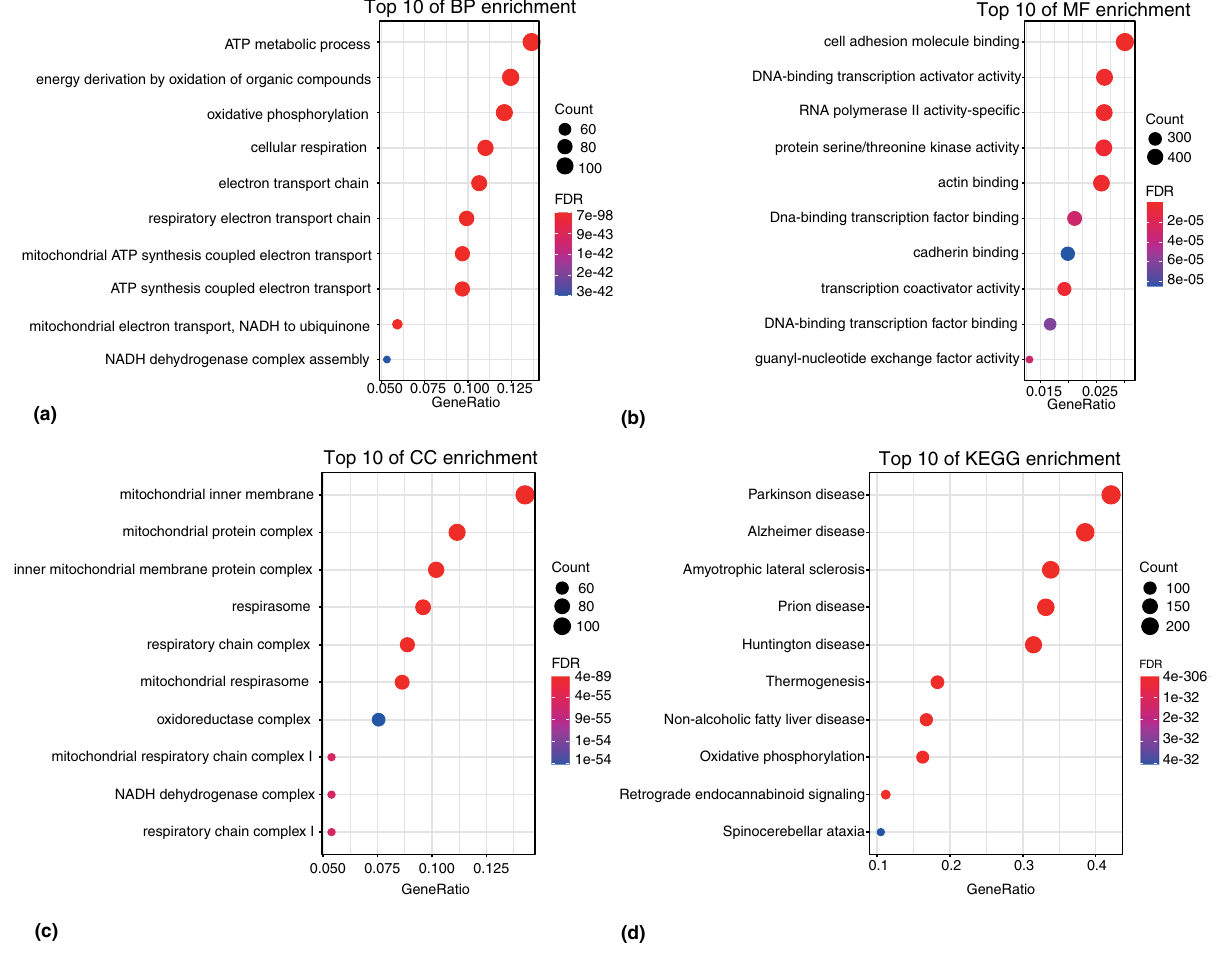
Figure 3. GO and KEGG enrichment analysis of the PD-related genes. (a) Biological process analysis. (b) Molecular function analysis. (c) Cellular component analysis. (d) KEGG pathway analysis. The color of the node represents significance, and the size of the node represents the number of genes enriched into the function.